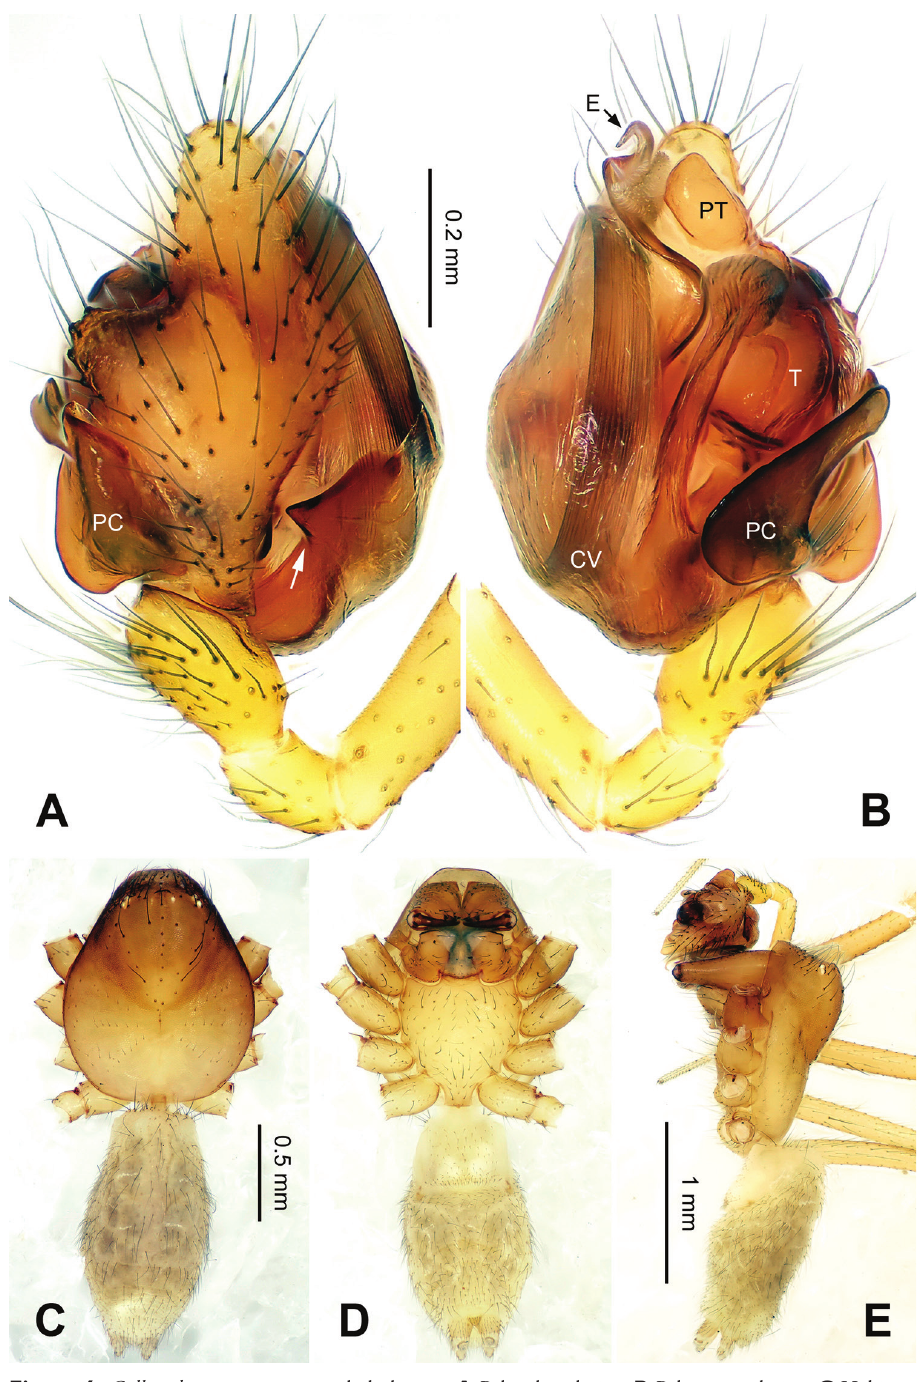
Figure 6. Callosa baiseensis sp. n., male holotype. A Palp, dorsal view B Palp, ventral view C Habitus, dorsal view D Habitus, ventral view E Habitus, lateral view. Scale bars: B as A ; D as C